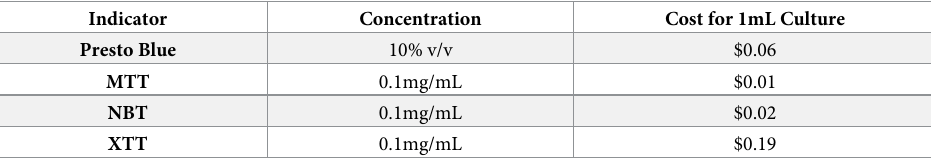
Table 1. Dye cost comparison. Indicator